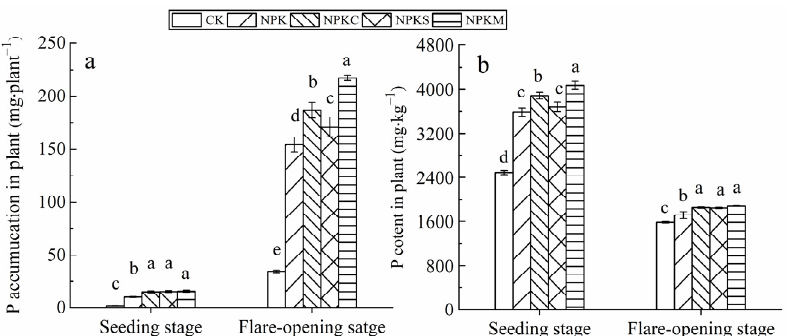
Figure 2. Effects of five years of fertilizer application on plant P accumulation ( a ) and plant P content ( b ). The different lowercase letters above the bars at the same stage indicate p < 0.05. CK: no fertilizer; NPK: chemical fertilizer; NPKC: chemical fertilizer and bone meal fertilizer; chemical fertilizer and crop straw NPKS; chemical fertilizer and bioorganic fertilizer